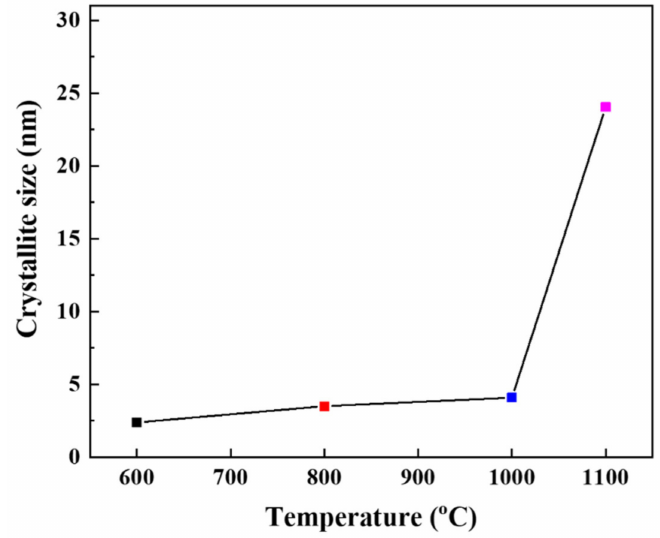
Figure 5. Crystallite size of alumina membranes (pH = 3.5 and t = 24 h) as a function of thermal treatment (by using the Scherrer